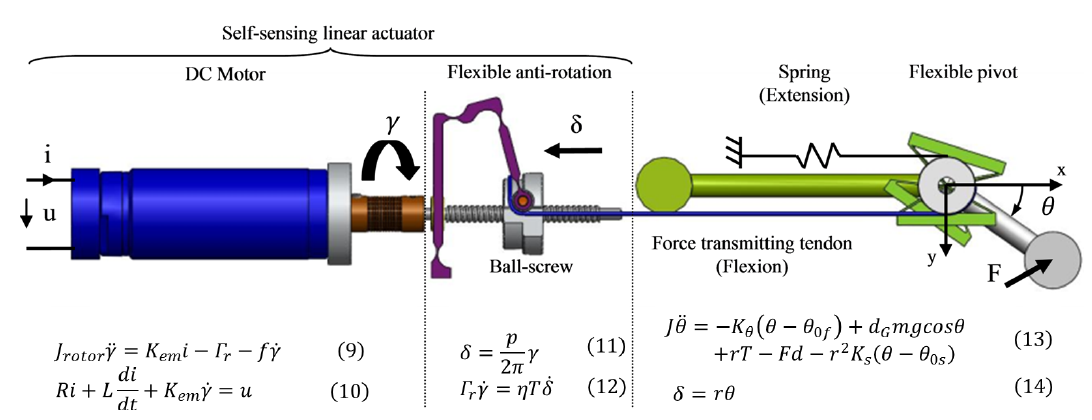
Figure 16. Mechatronic model of the self-sensing actuated joint, including the anti-rotation system and the X 2 pivot. Table 2. Description of the model